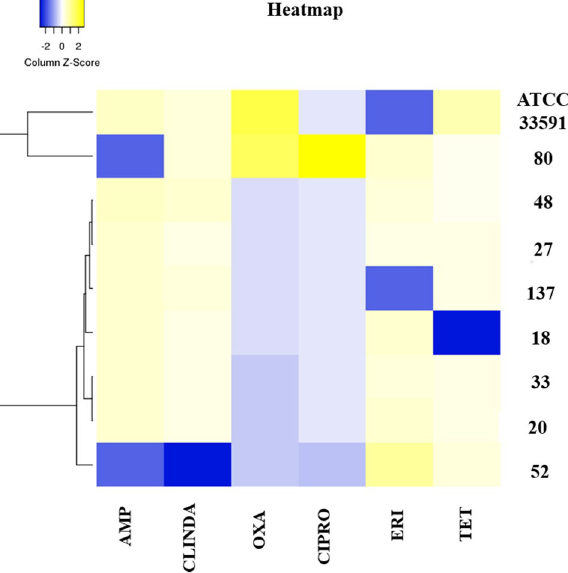
Figure 1. Heatmapper platform formed two clusters according of differential evaluation of the modulating activity at citral 5 mg/mL (0.5%) on antibiotics ampicillin (AMP), ciprofloxacin (CIPRO), clindamycin (CLINDA), erythromycin (ERY), oxacillin (OXA), tetracycline (TET) on MRSA (18, 20, 27, 33, 48, 52, 80, 137) and ATCC 33591 strains. The yellow segments represent greater modulation of 0.5% citral on antibiotics, and the blue segments represent less